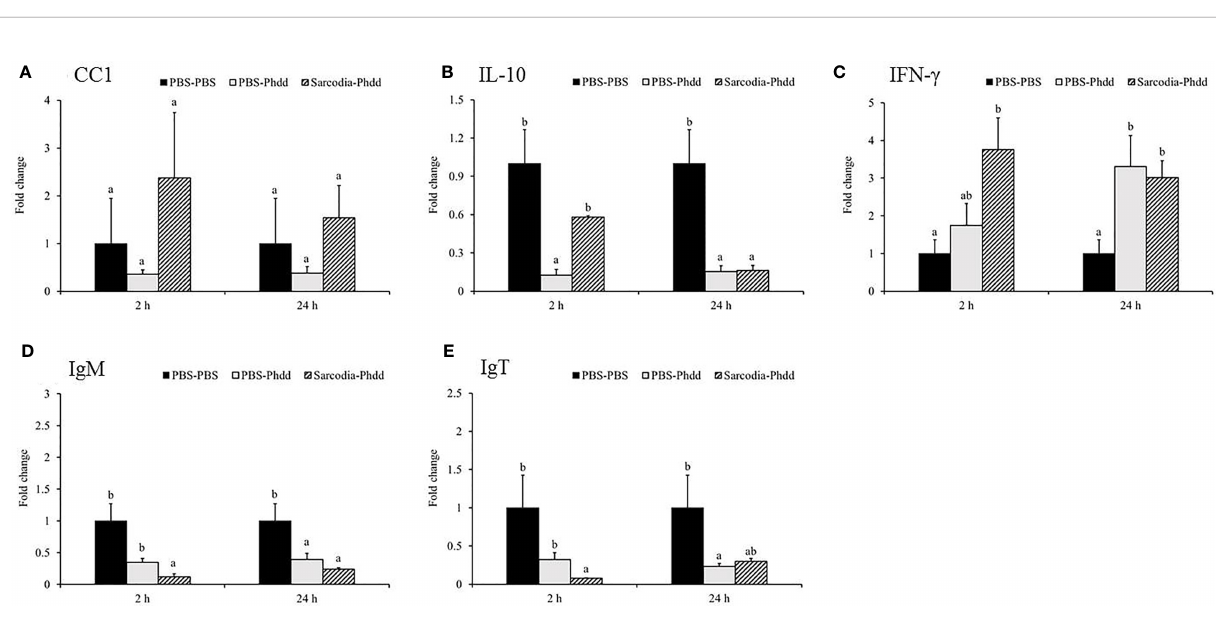
FIGURE 10 | Comparison of transcript level of immune genes in the spleen tissue of fi sh intraperitoneal injected with PBS and Sarcodia suiae water extract after challenge with Photobacterium damselae subsp. damselae ( Phdd ). The relative expression pro fi le of (A) CC1 , (B) IL-10 , (C) IFN- g , (D) IgM , and (E) IgT in the spleen samples was analyzed. The values are shown as mean + SEM (N = 3). Signi fi cant differences ( p < 0.05 ) are indicated by different